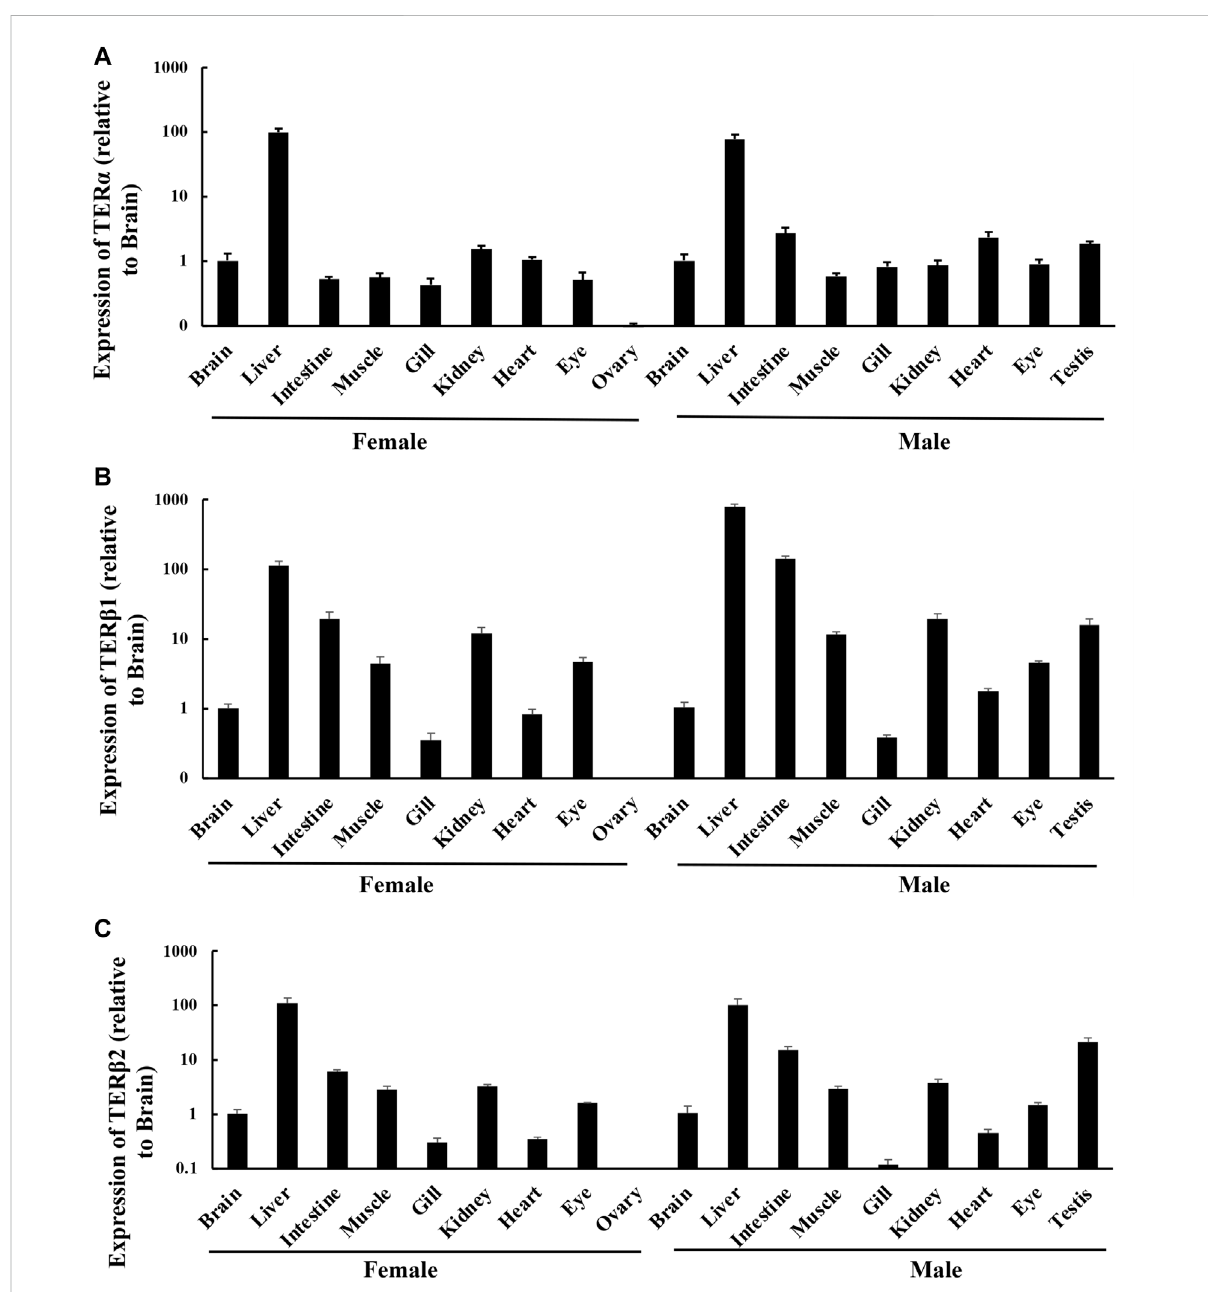
FIGURE 1 Expression levels of ERs in different tissues in adult T. albonubes . Expression of ter α (A) , ter β 1 (B) , and ter β 2 (C) . The expression of ERs in the different tissues is shown relative to the brain of females and males. The data are expressed as mean ± standard error of 15 female fi sh and 15 male fi